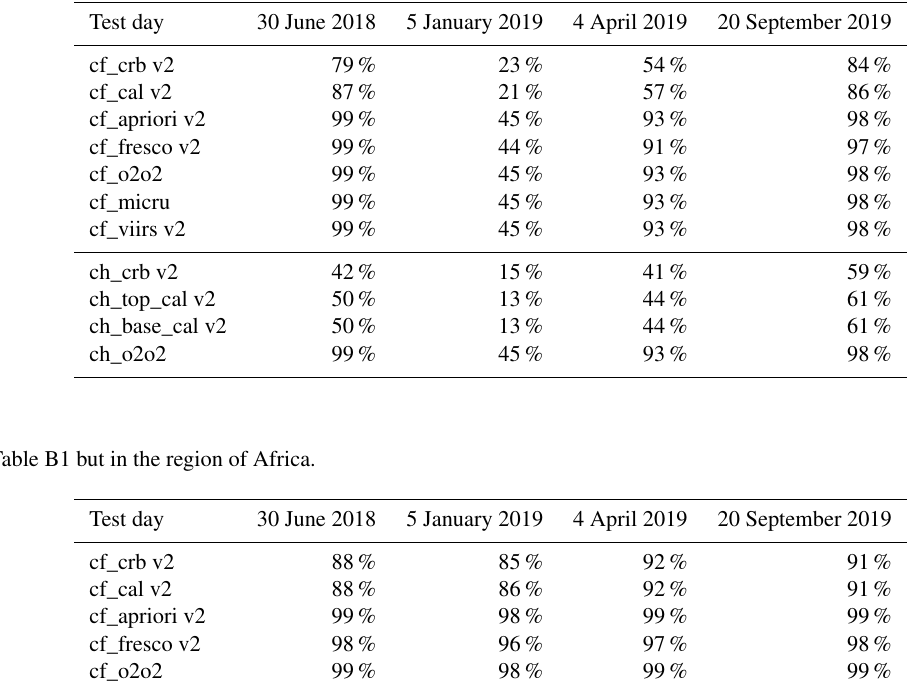
Table B1. Overview of the percentage of the number of available cloud fraction and cloud height values of all values in the region of Europe after quality flagging with a quality value of 0.5, comparing cf_fit v2 or ch_fresco* v2 with the other products.